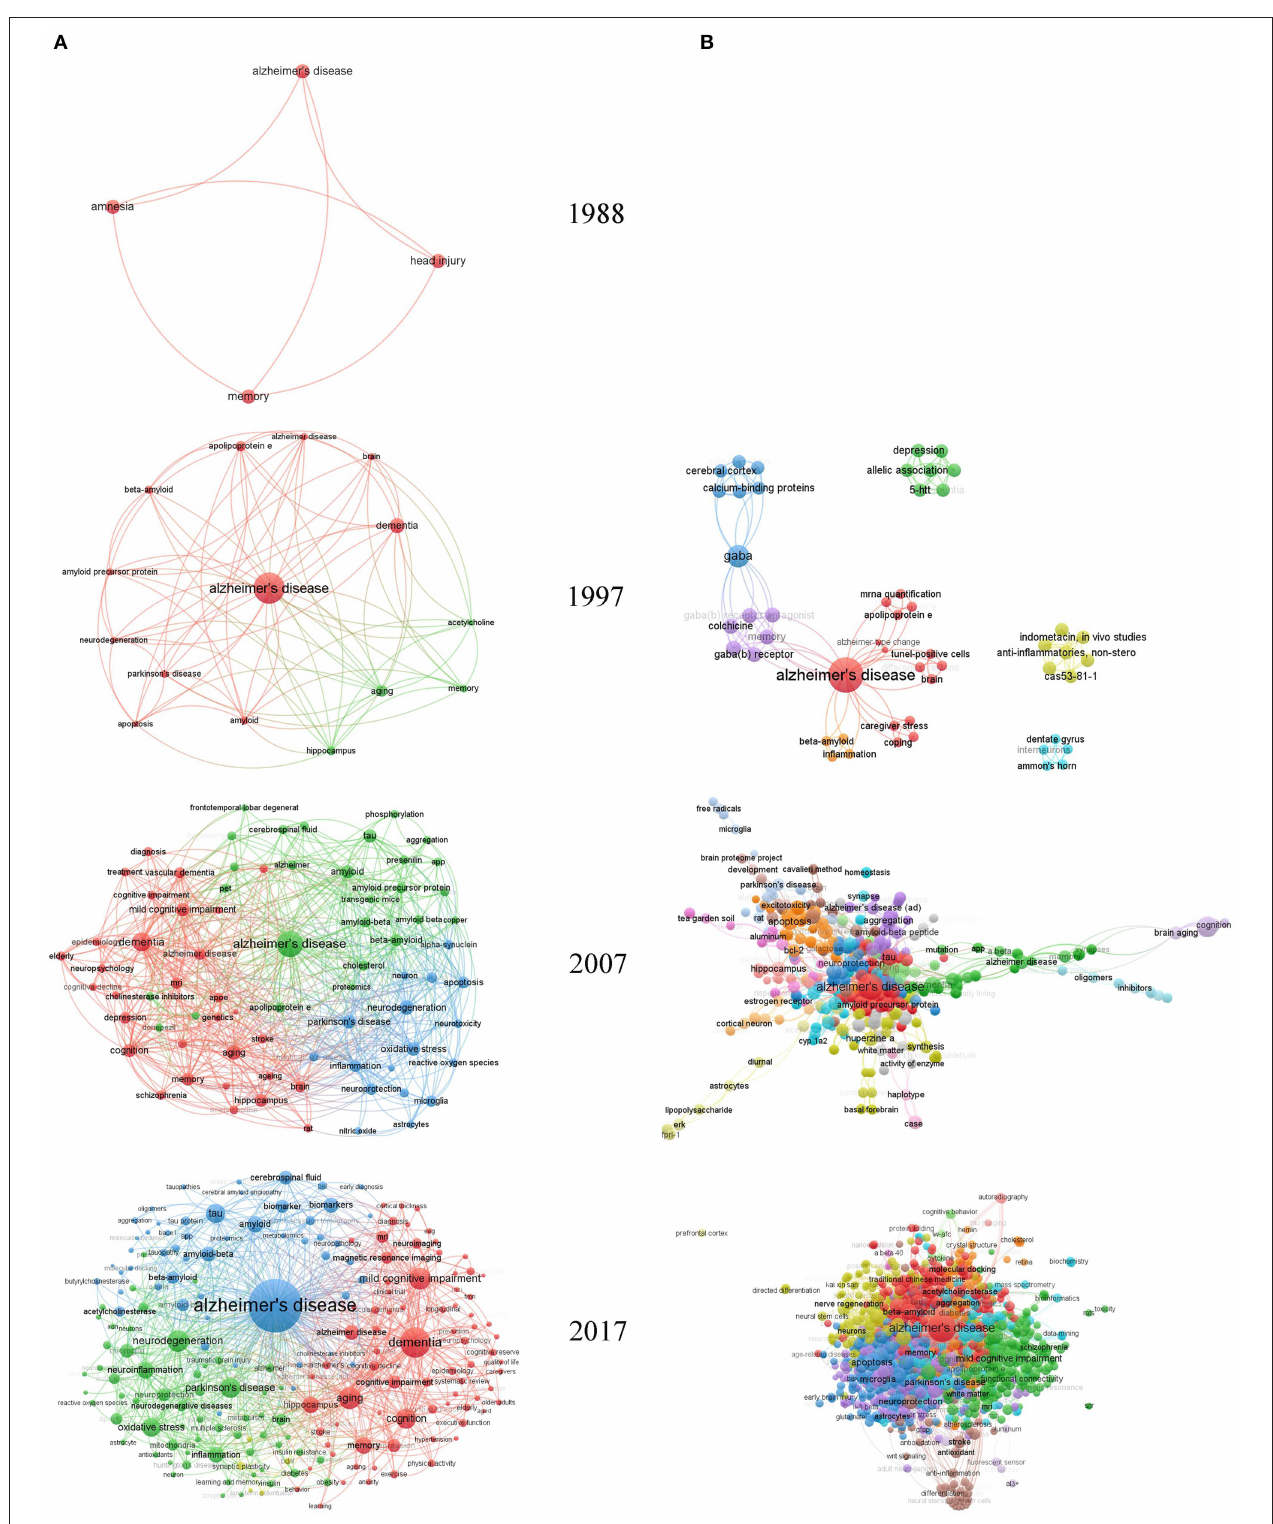
FIGURE 4 | Keyword maps globally and in China. (A) Global keyword maps. (B) Keyword maps in China. In this visualized network, each keyword is represented by a node. Node size reflects the number of publications in the node, and the distance between two nodes indicates the connectivity of the nodes as determined by co-occurrences. The larger the number of publications for which two nodes are both found, the stronger the relationship between the nodes. VOSviewer has its own clustering technique based on citation relations between clusters. Colors represent groups of nodes that are relatively strongly related to each other.